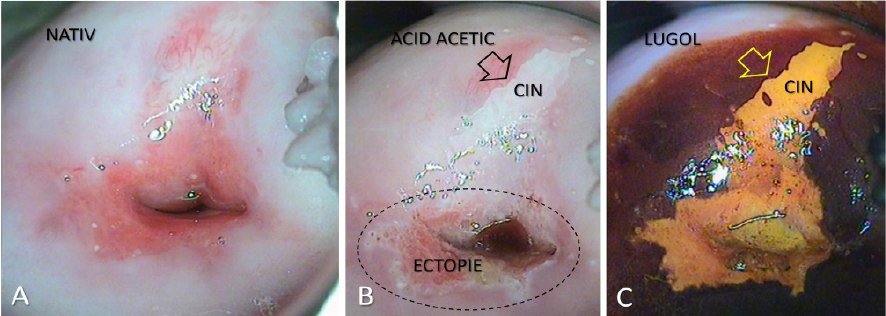
Figure 1. Colposcopic examination showing CIN 1 cervical lesion. ( A ): After the application of saline, native appearance; ( B ): After the application of acetic acid: Fine, bright-white acetone-white epithelium (arrow), visible; ( C ): After applying the Lugol solution: iodine-negative lesion, with well-defined edges.